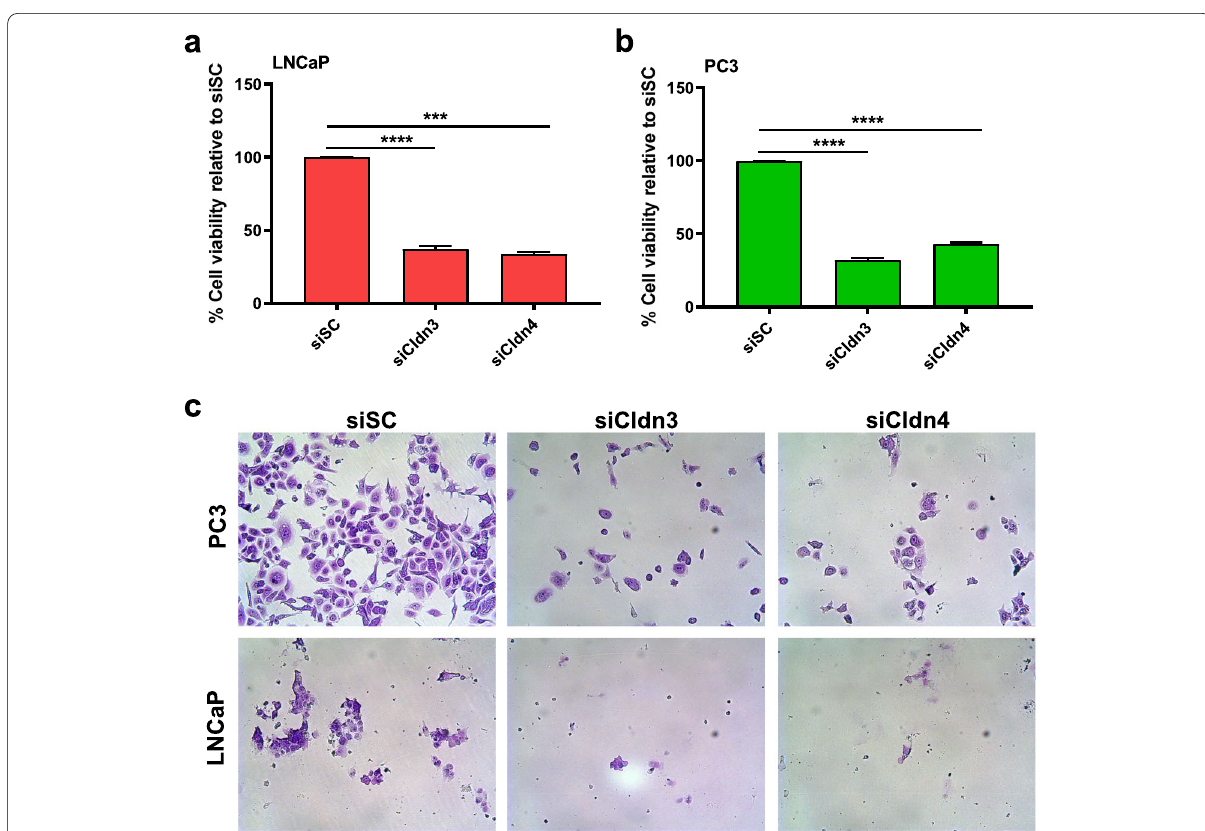
Fig. 4 The effects of knocking down Cldn3 and Cldn4 on cell viability. Cell viability was assessed on human ( a ) LNCaP or ( b ) PC3 prostate cancer cells following siCldn3 or siCldn4 treatment. c Crystal violet staining was performed to visualize viable cells. Data are shown as mean independent experiments. *** represents p < 0.001 and **** represents p <